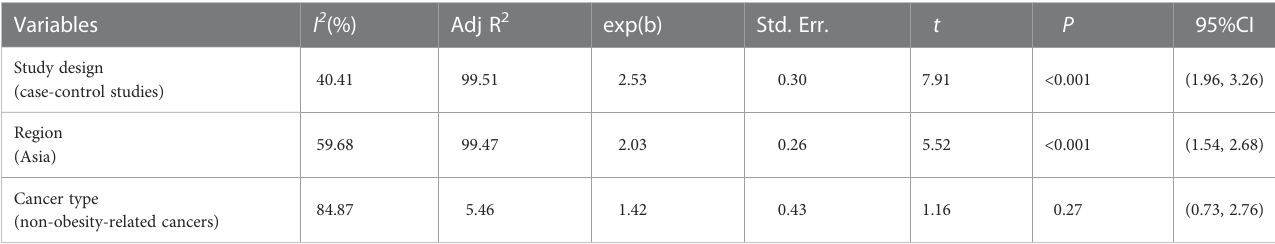
TABLE 4 Meta-regression for cancer